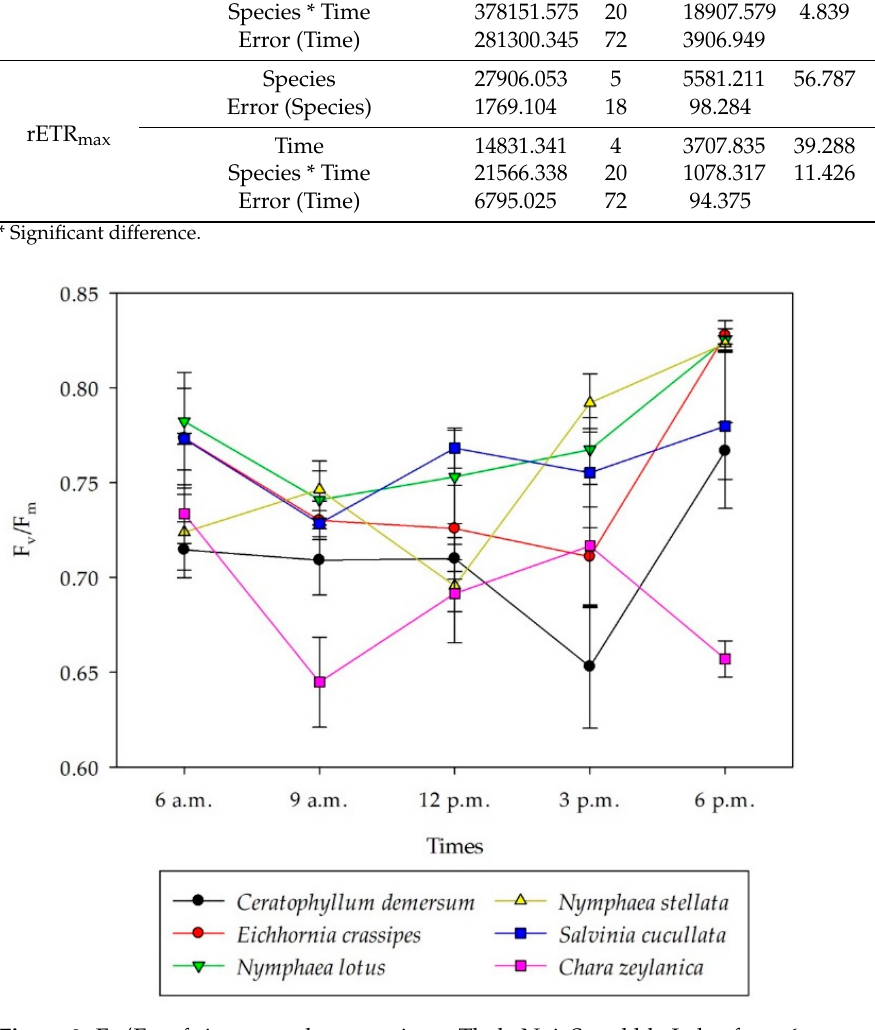
Figure 2. F v / F m of six macrophyte species at Thale Noi, Songkhla Lake, from 6 a.m. to 6 p.m. for each species ( n = 4). Data represent mean ± SE.